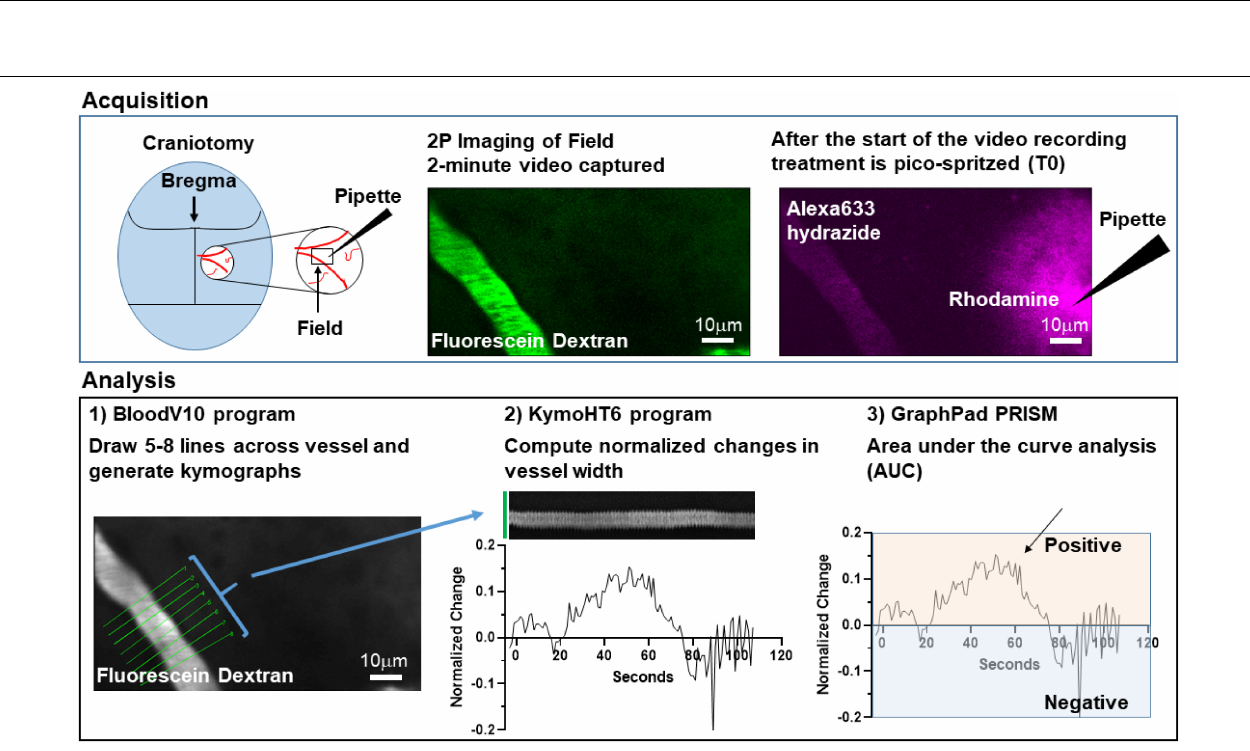
FIGURE 3 | Schematic model of methods used to analyze changes in arteriole